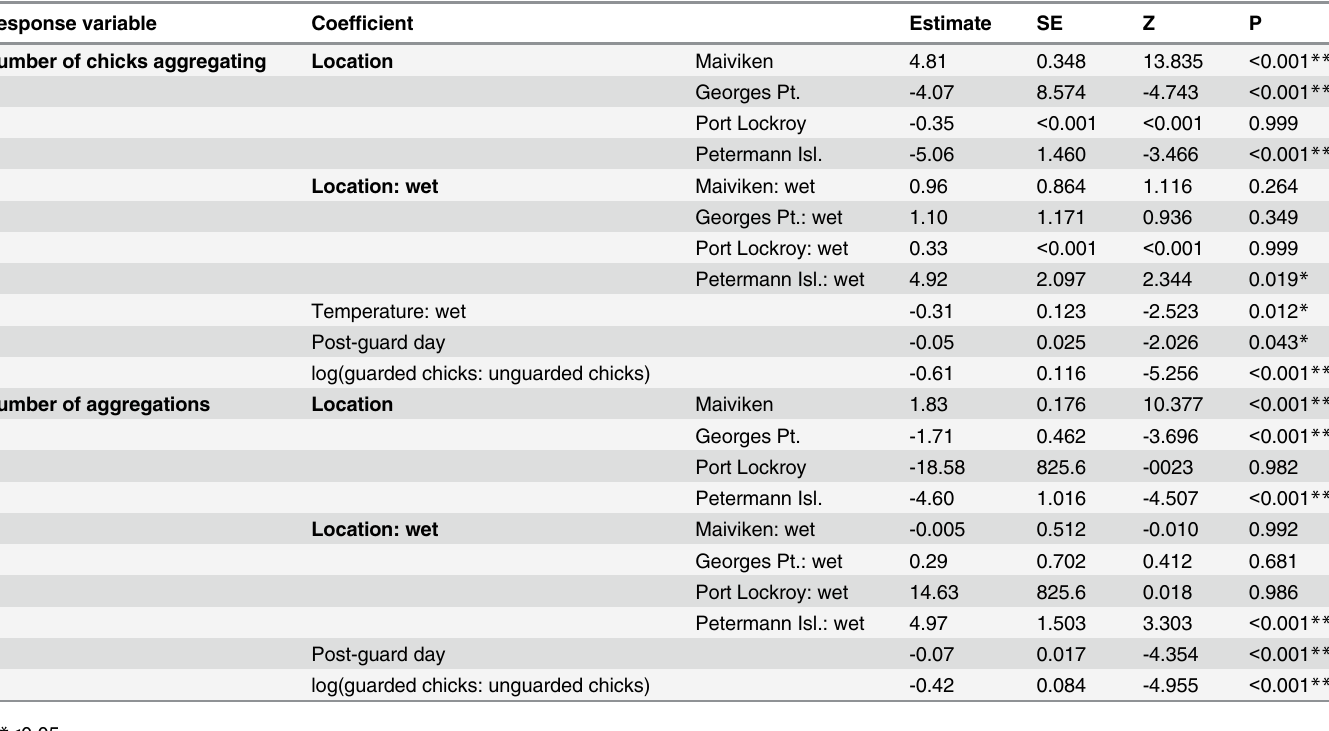
Table 1. Results from a negative binomial GLM on the number of gentoo penguin chicks aggregating (residual deviance: 239.29 on 421 degrees of freedom) and a Poisson GLM on the number of aggregations per nest unit (residual deviance: 232.61 on 426 degrees of freedom) for each coeffi- cient included in the